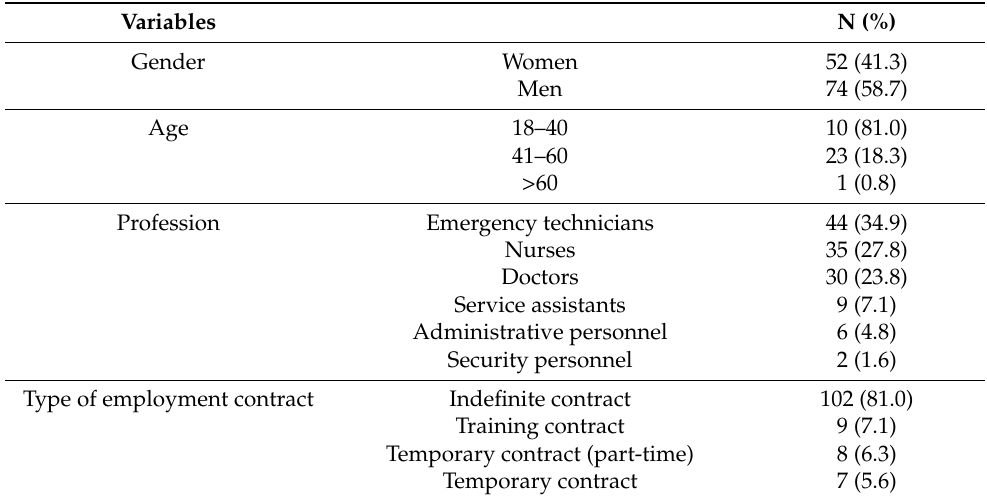
Table 1. Sociodemographic variables of emergency